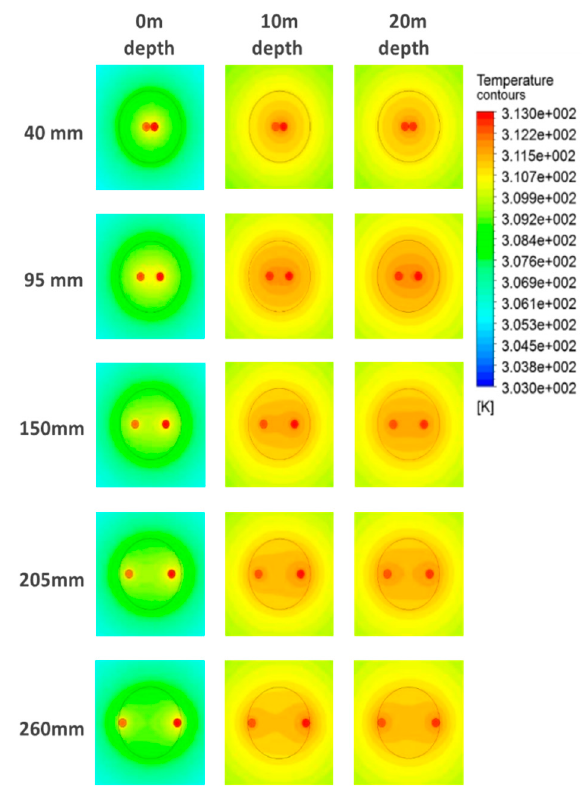
Figure 6. Temperature distributions at three different locations along the borehole depth (20 m) for the five different shank-spaces simulated.